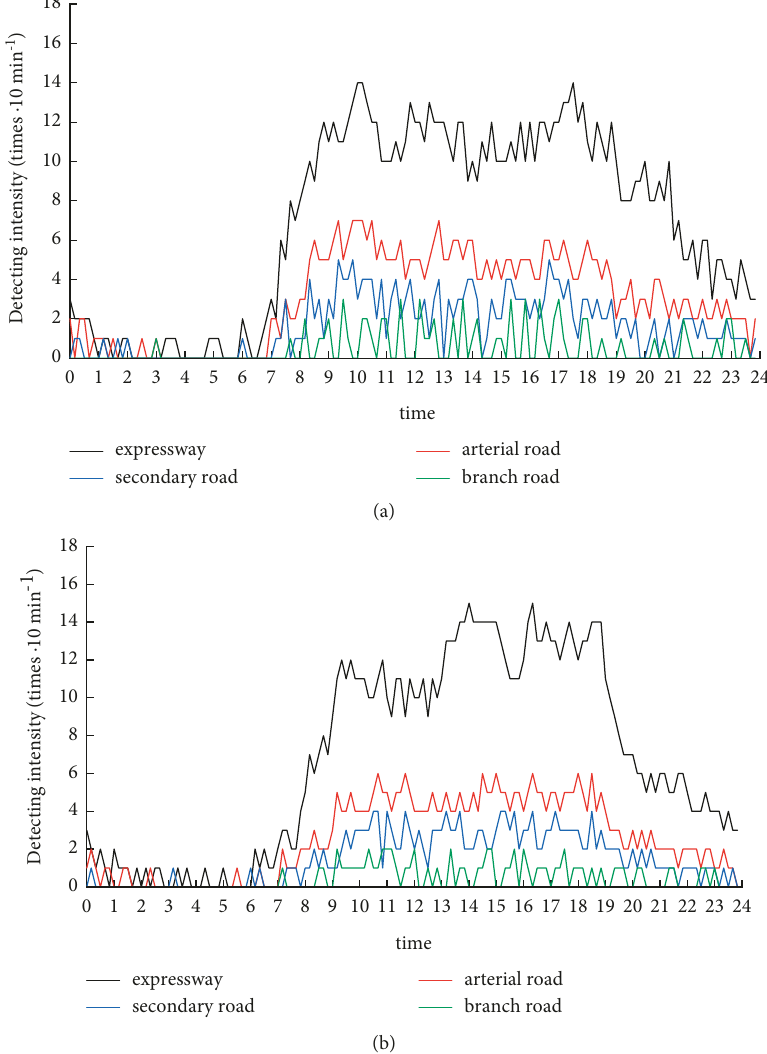
Figure 3: Detecting intensities of ride-hailing vehicles on a working day and a holiday. (a) Working day. (b)